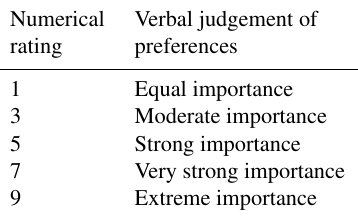
Table 2. Scale of relative importance used to compare criteria in AHP and ANP (Saaty,